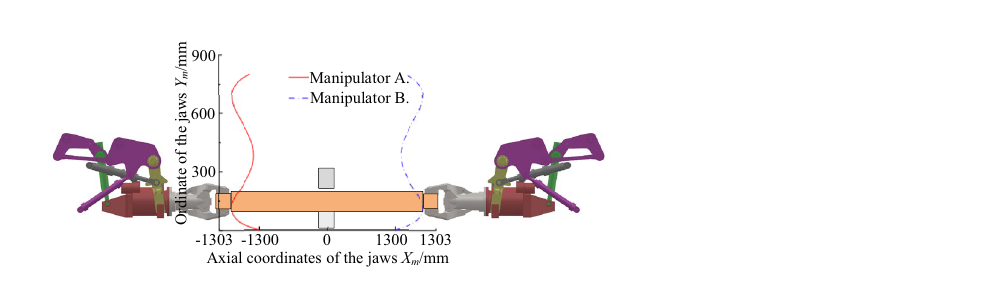
Figure 2. The movement track of two forging